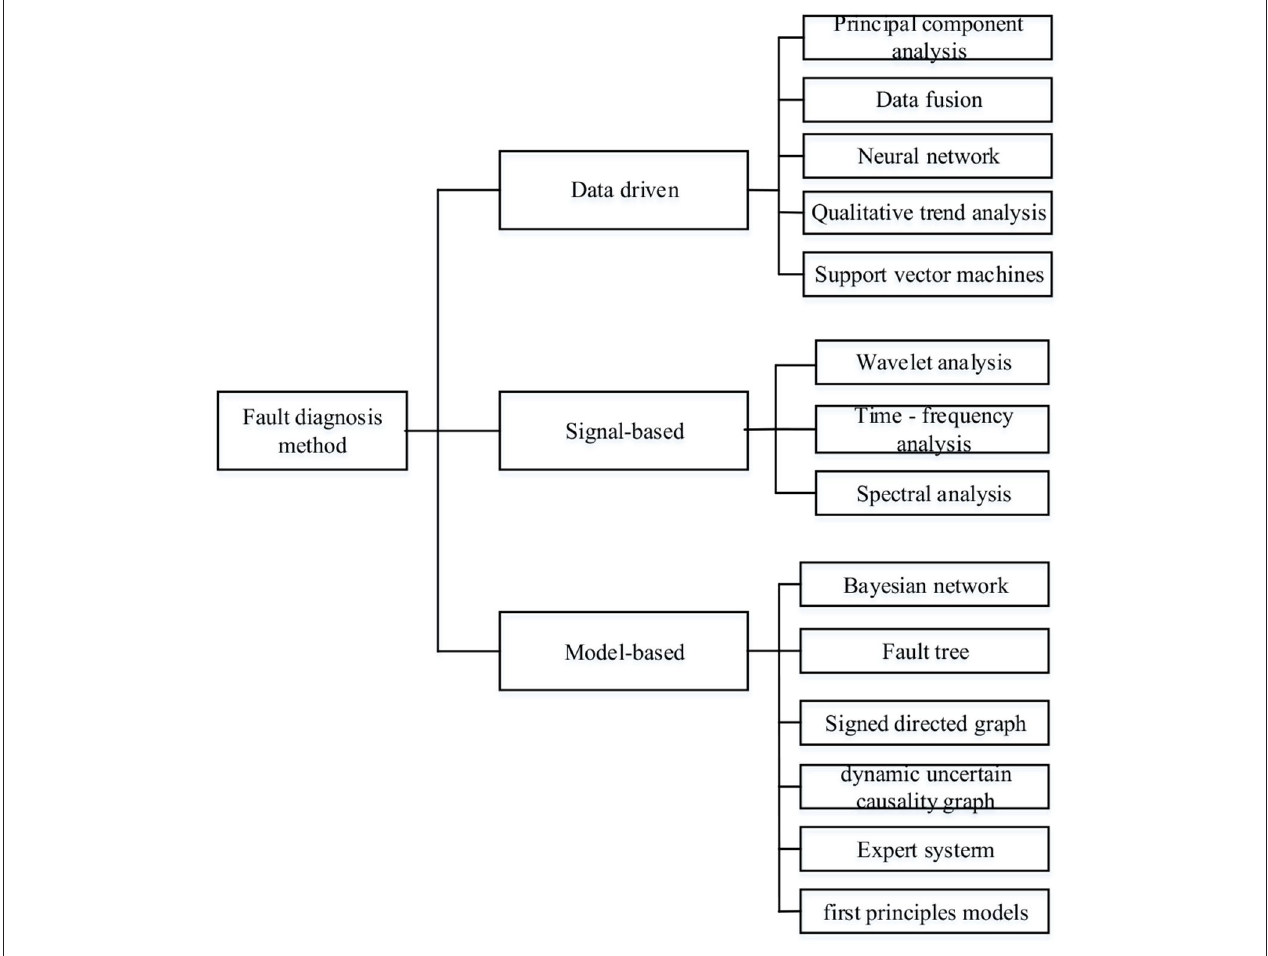
FIGURE 2 | Classification of common fault diagnosis methods.